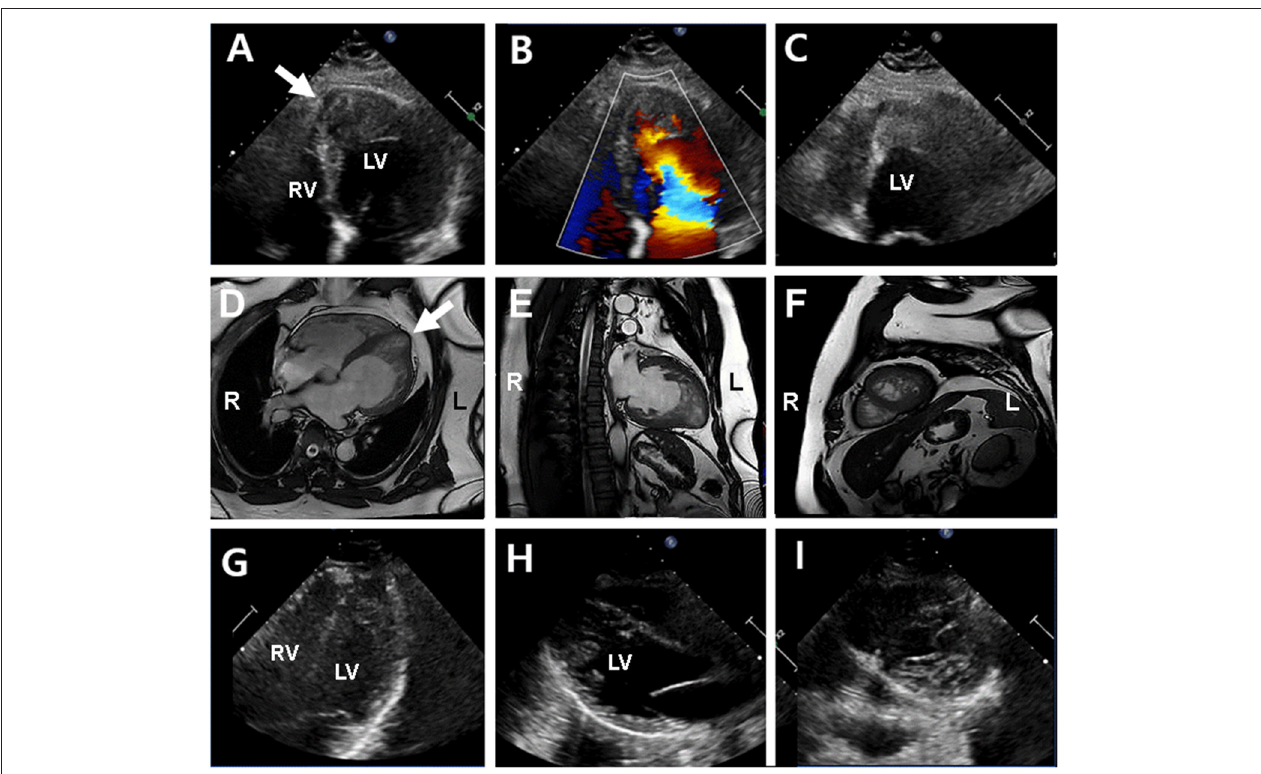
FIGURE 3 | Echocardiography and cardiac magnetic resonance imaging (cMRI) in the proband’s father (II-1) (upper and middle panel) and sister (III-1) (lower panel). (A–C) Echocardiography showed left ventricular hypertrophy and apical echogenic mass or dense trabeculation and apical septal aneurysm (arrow) in the proband’s father. (D–F) cMRI determined dense trabeculation and focal apical septal aneurysm that considered as hypertrophic LVNC in the proband’s father. (G–I) Echocardiography in proband’s sister showed normal left ventricular function and geometry except for prominent trabeculation of left ventricle that diagnosed with isolated LVNC in the proband’s sister.